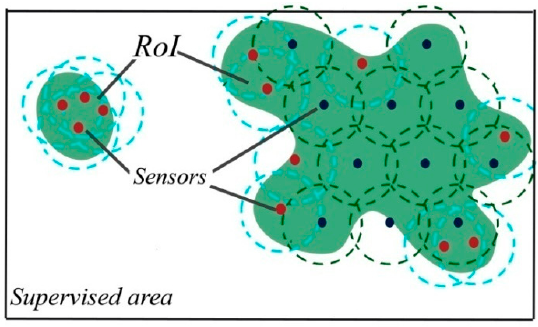
Figure 10. Topology with optimized sensor positions.